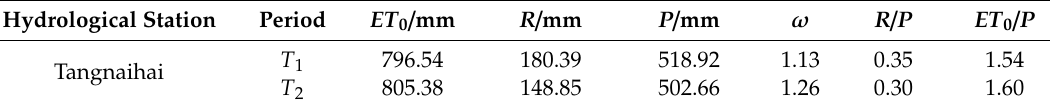
Table 2. The methodological hydrological variable eigenvalues.